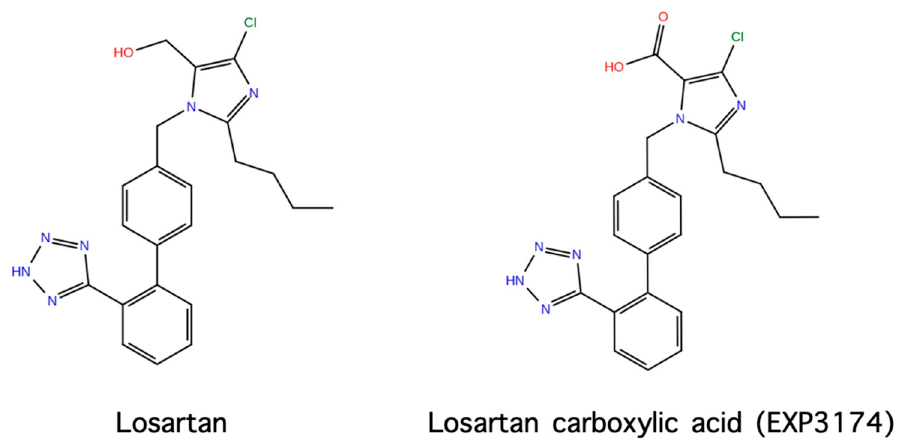
Figure 8. Losartan and the active metabolite losartan carboxylic acid.